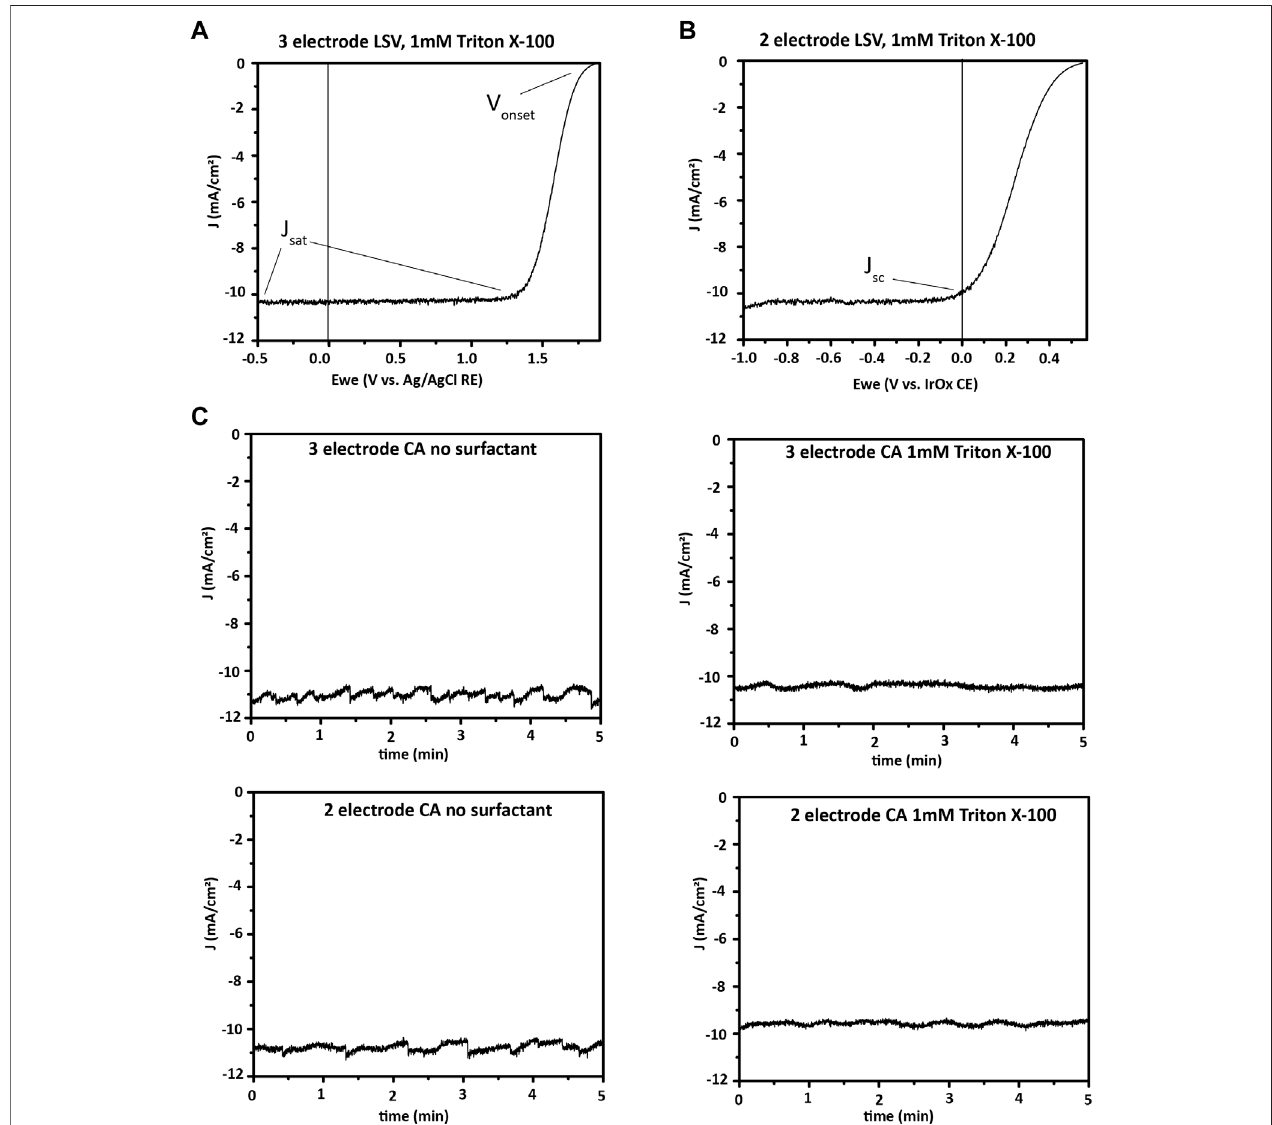
FIGURE 13 | Broadband PEC characterization. (A) , three-electrode and (B) , two-electrode linear sweep voltammetry (LSV or J-V) showing onset potential, saturation current density, and short-circuit current density for a III – V photoelectrode, in 0.5 M H 2 SO 4 with 1 mM Triton X-100 surfactant. (C) , Photocurrent at 1-sun illumination and 0 V applied potential for a III – V photoelectrode. A comparison ismade between two- and three-electrode bias free water splitting, and another between electrolyte with and without 1 mM Triton X-100 as surfactant effects on bias free water splitting. The electrode is seen to have similar currents in two- and three- electrode formats, with less variation in current over time when surfactant was used in the electrolyte. Surfactants such as Triton X-100 decrease the size of hydrogen bubbles formed, which prevents formation of large bubbles blocking portions of the photoelectrode. However, surfactant may decrease the average current, as seen here, while providing less variation over time by eliminating large